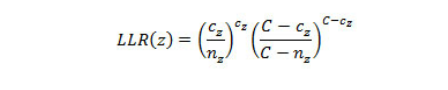
Figure 5. SaTScan equation. C = total number of cases, C z = observed number of cases in window z, LLR = likelihood ratio, n z = expected number of cases or population in window z.